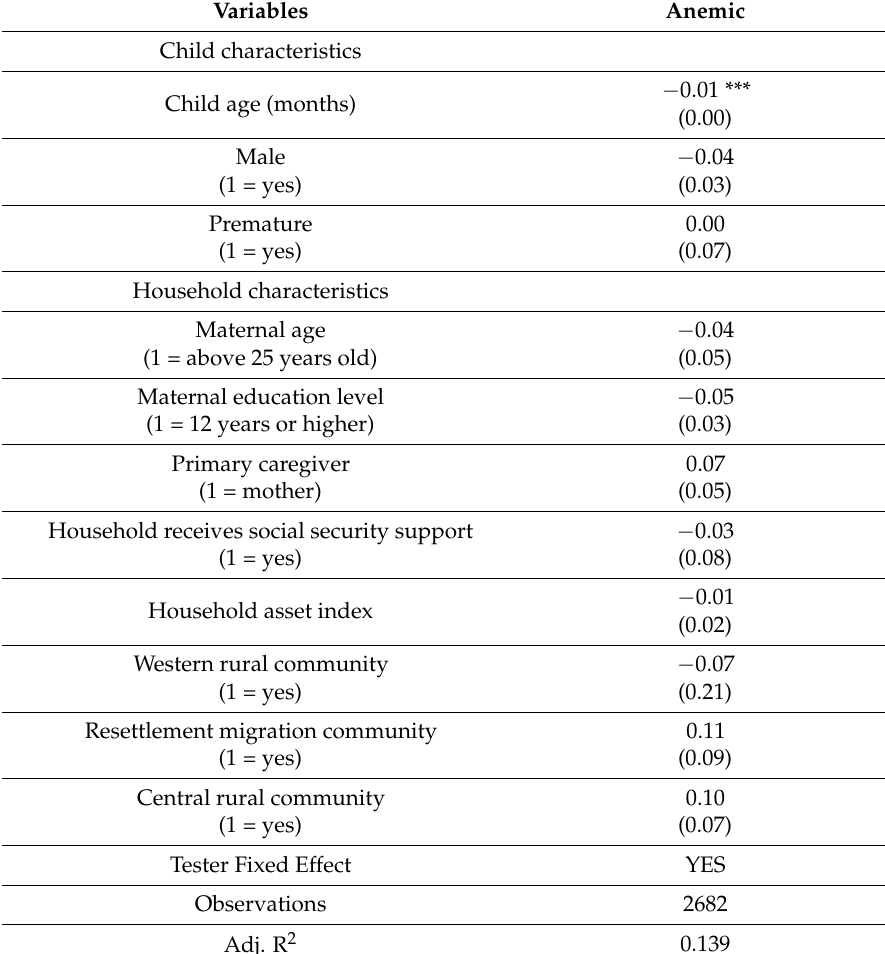
Table 5. Correlations between anemia and infant/household